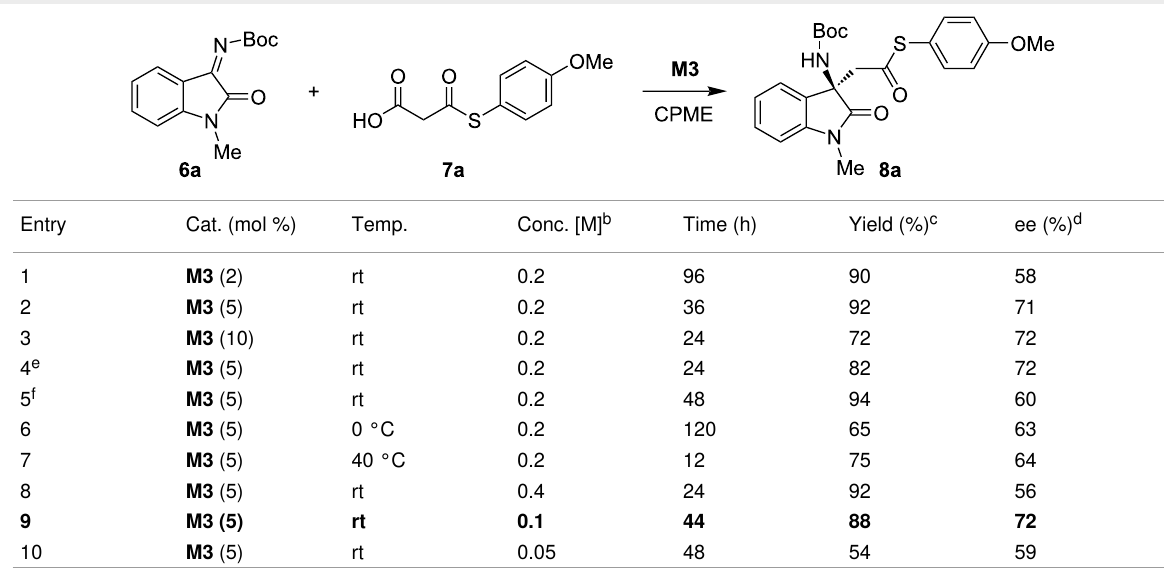
Table 3: Evaluation of catalyst loading, reaction temperature, and concentration a